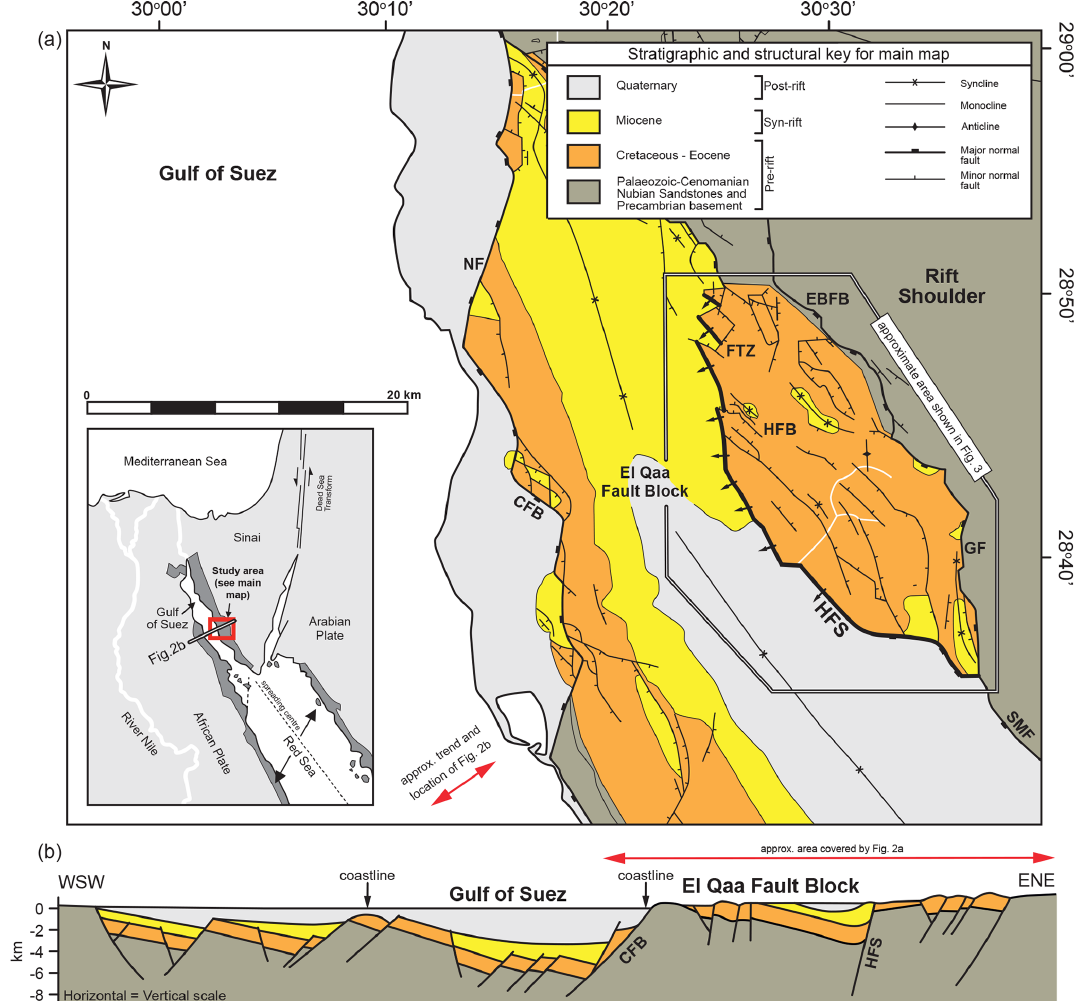
Figure 2. (a) Simplified geologic map of the El Qaa Fault Block (modified from Moustafa and El-Raey, 1993, and Sharp et al., 2000). B-SF: Baba–Sidri Fault; NF: Nezzazat Fault; CFB: Coastal Fault Belt; FTZ: Feiran Transfer Zone; EBFB: Eastern Boundary Fault Belt; HFS: Hadahid Fault System; GF: Gebah Fault; SMF: Sinai Massif Fault; HFB: Hadahid Fault Block. Inset map shows the regional plate tectonic setting of the Gulf of Suez Rift. Dark-grey shading indicates area containing structures and stratigraphic units related to Oligo-Miocene rifting. (b) Geoseismic section across the central dip province of the Gulf of Suez Rift (modified from Patton et al., 1994). Location of the section is shown in (a)